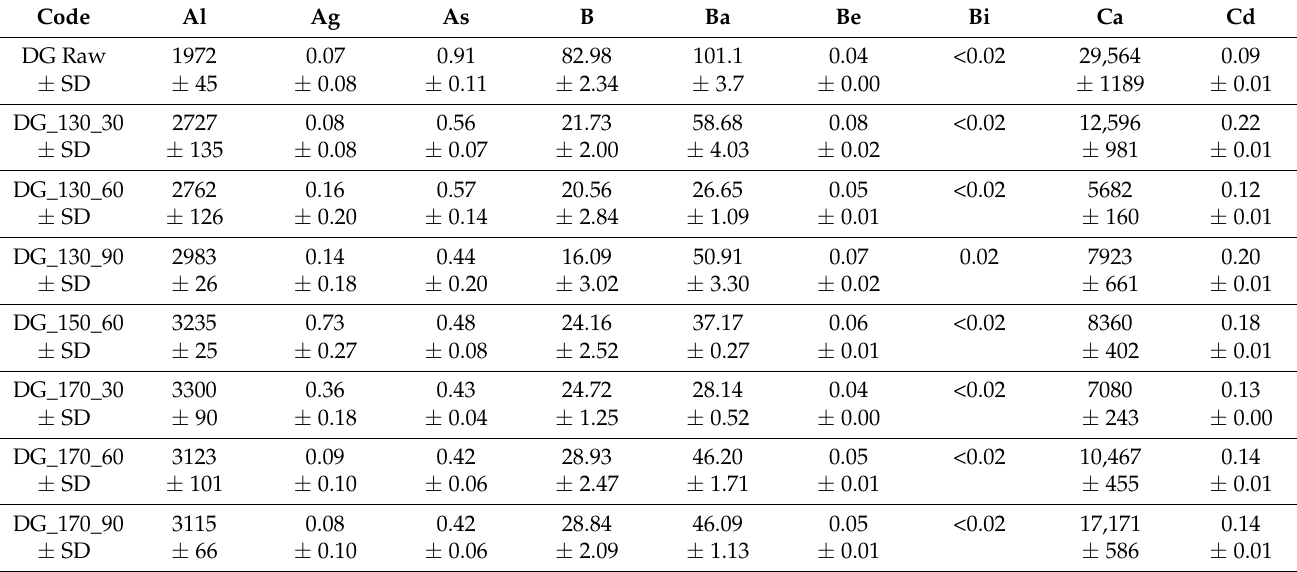
Table A2. Mean values ± standard deviations (SD) for different element concentrations in the digestate (DG) and forest residue (FR) hydrothermally treated at 130, 150 or 170 ◦ C with a holding time of 30, 60 or 90 min. Excluded measurements are highlighted with